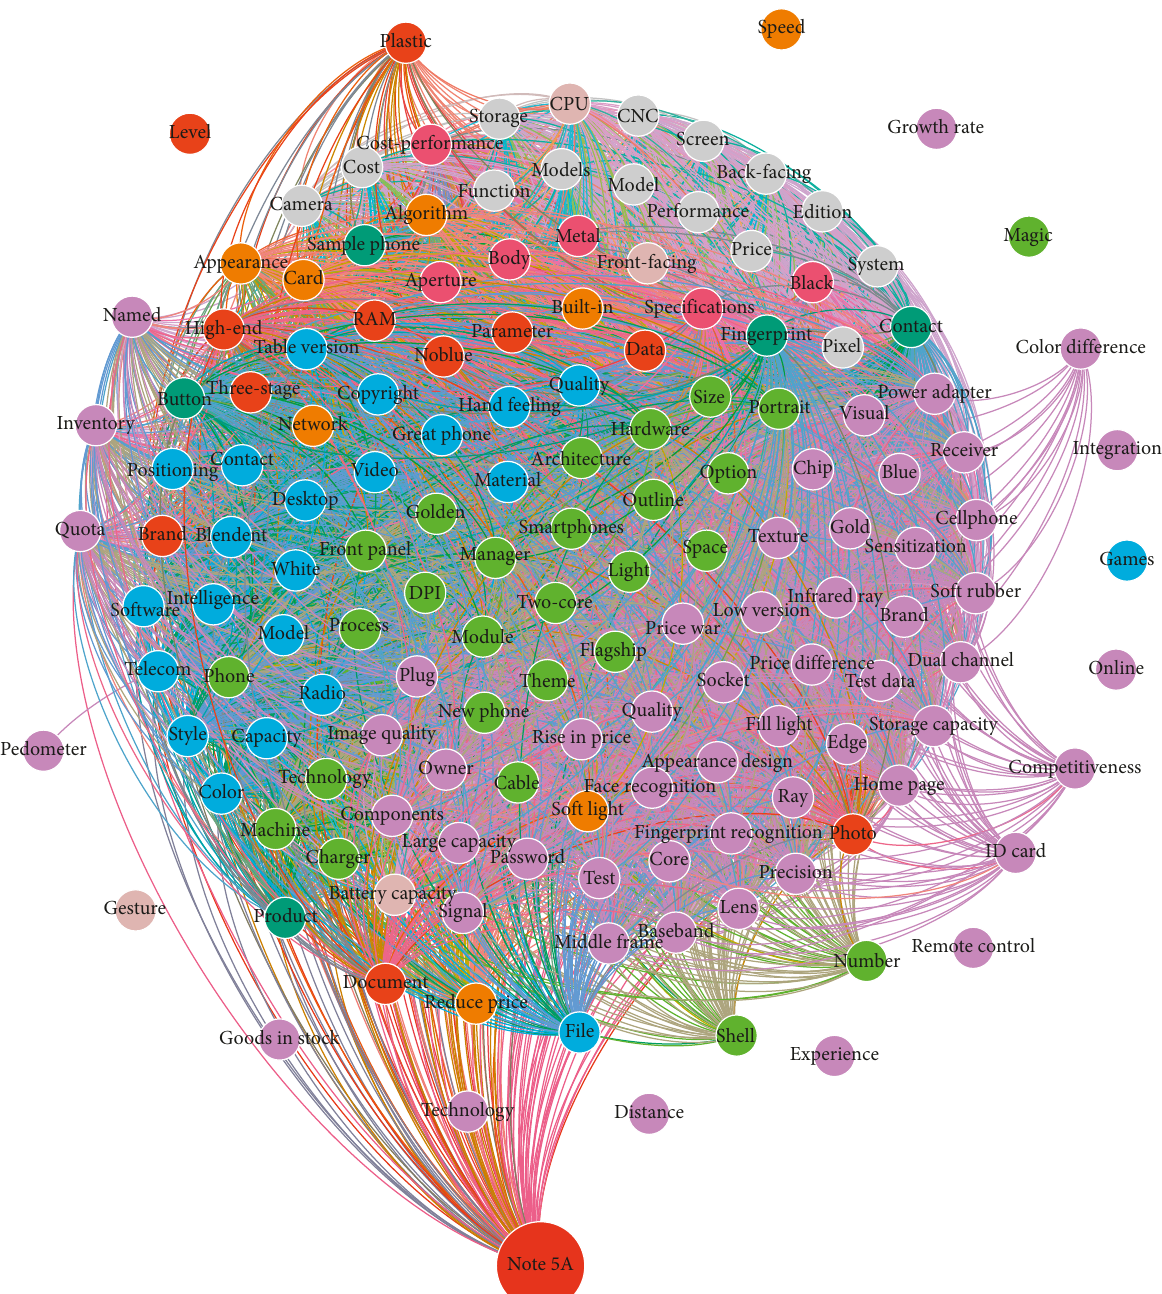
Figure 15: Visualized co-creation product